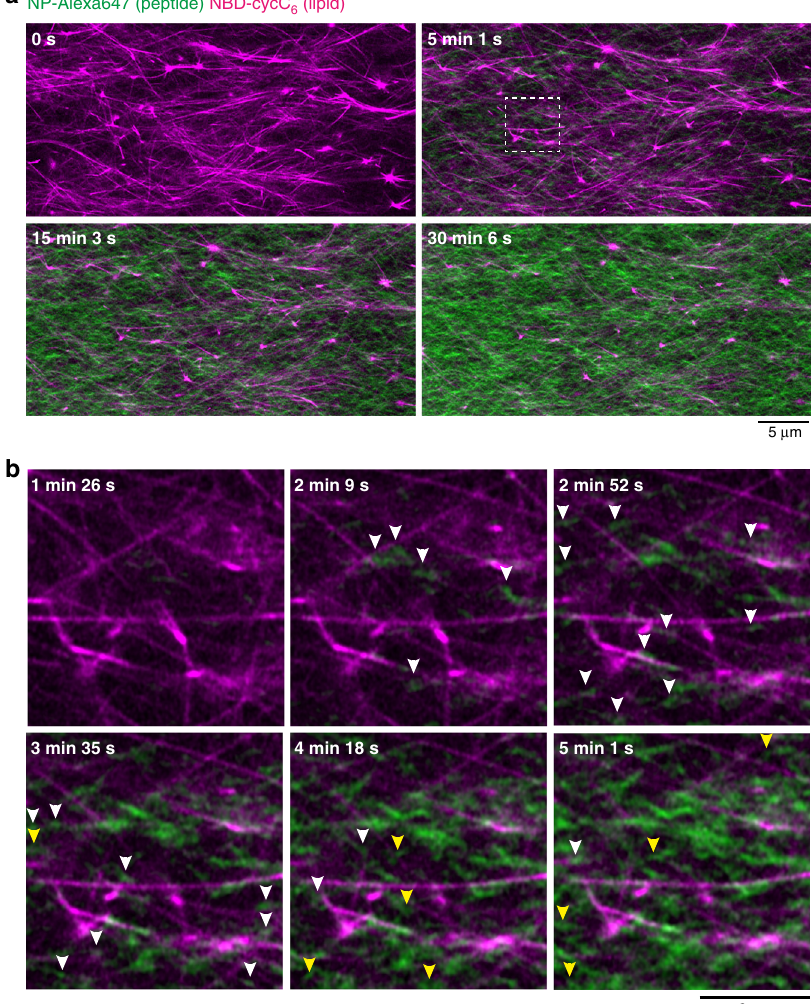
Fig. 4 Real-time imaging of the formation process of the interpenetrated self-sorting network. a Time-lapse imaging of the formation of the interpenetrated SDN. b Magni fi ed view of the formation of peptide-type nano fi bers on the surface of lipid-type nano fi bers (highlighted by white arrows) and in the water layer (highlighted by yellow arrows). The white square region in Fig. 4a was magni fi ed. Green: NP-Alexa647 , magenta: NBD-cycC 6 . Condition: [ Ald-F(F)F ] = 4.3 mM (0.20 wt%), [ Phos-MecycC 5 ] = 2.4 mM (0.15 wt%), [ O -benzylhydroxylamine] = 4.3 mM (1.0 eq), [ NP-Alexa647 ]